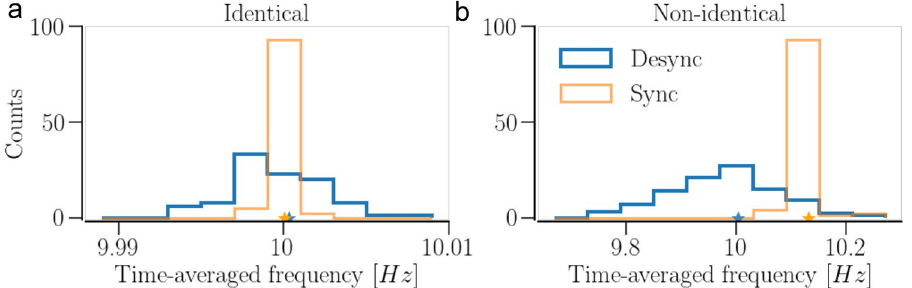
Figure 2. Time-averaged frequency distributions in the synchronized and desynchronized states of a network of N = 100 oscillators with STDP. ( a ) and ( b ) show networks of identical and non-identical oscillators, respectively. The distribution averages (network-averaged frequencies) are marked by stars with corresponding colors. Parameters are a = 0.3 and γ = 3 for the identical oscillators; a = 0.3 and γ = 15 for the non-identical oscillators; the average node degree density (NDD), (cid:31) β (cid:30) is 0.2 for the identical, and 0.4 for the non-identical oscillator